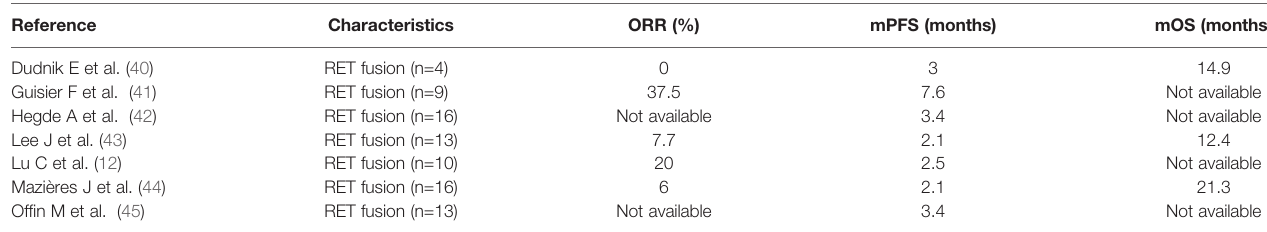
TABLE 2 | ICIs in RET fusion